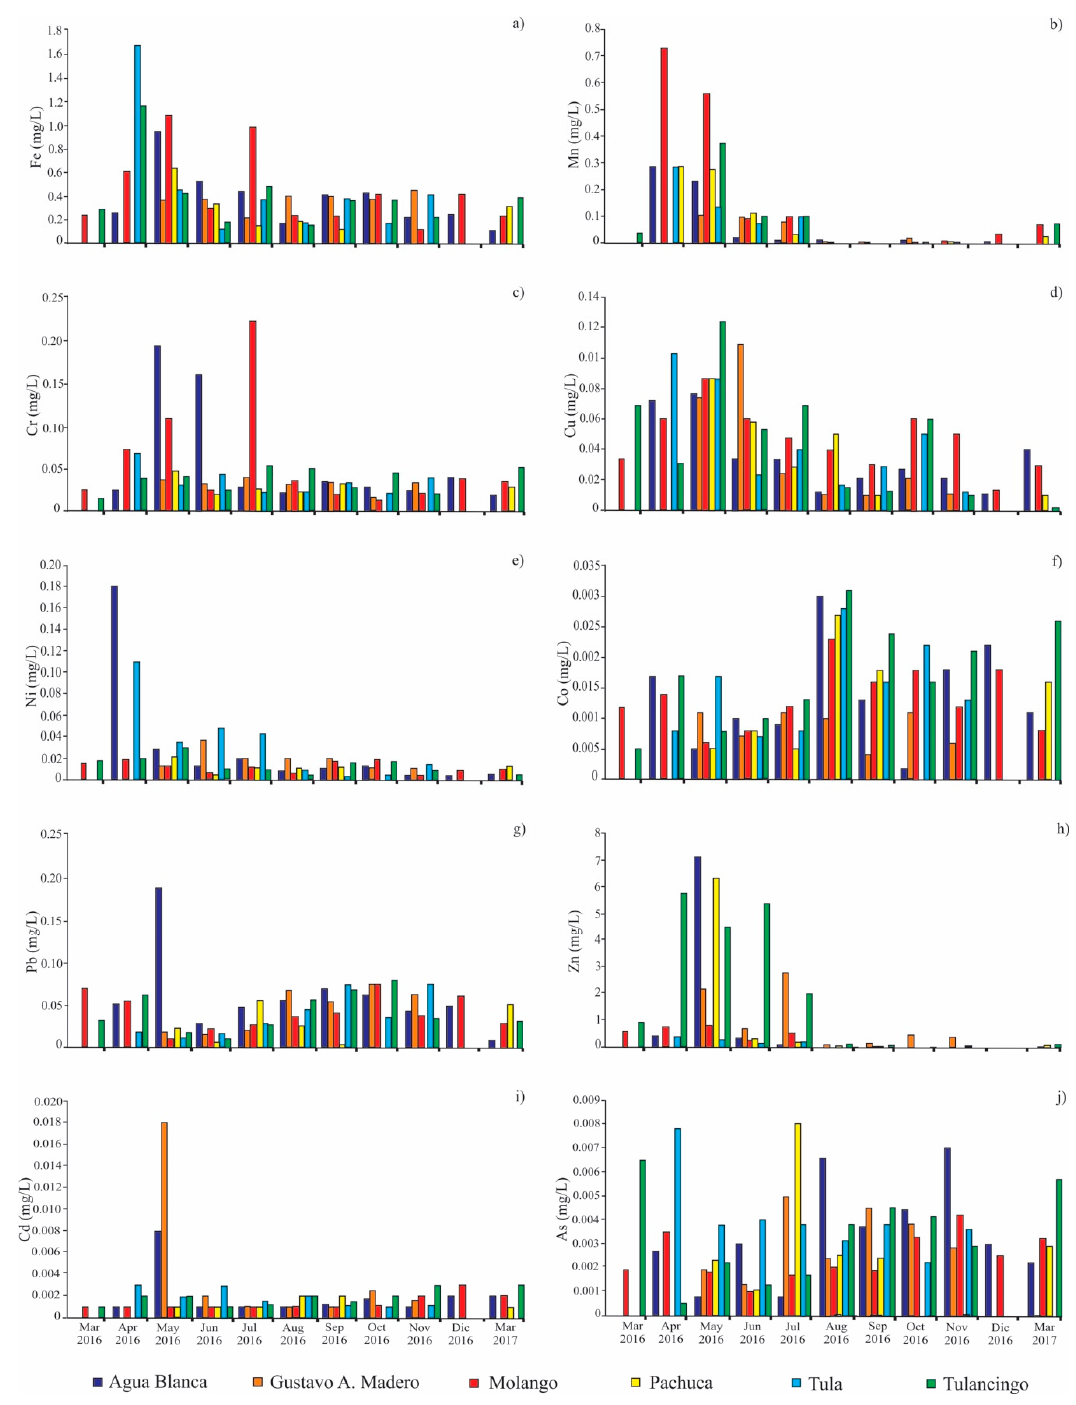
Figure 2. ( a – j ) Spatial and temporal distribution pattern of trace metals in precipitation of Central Mexico.